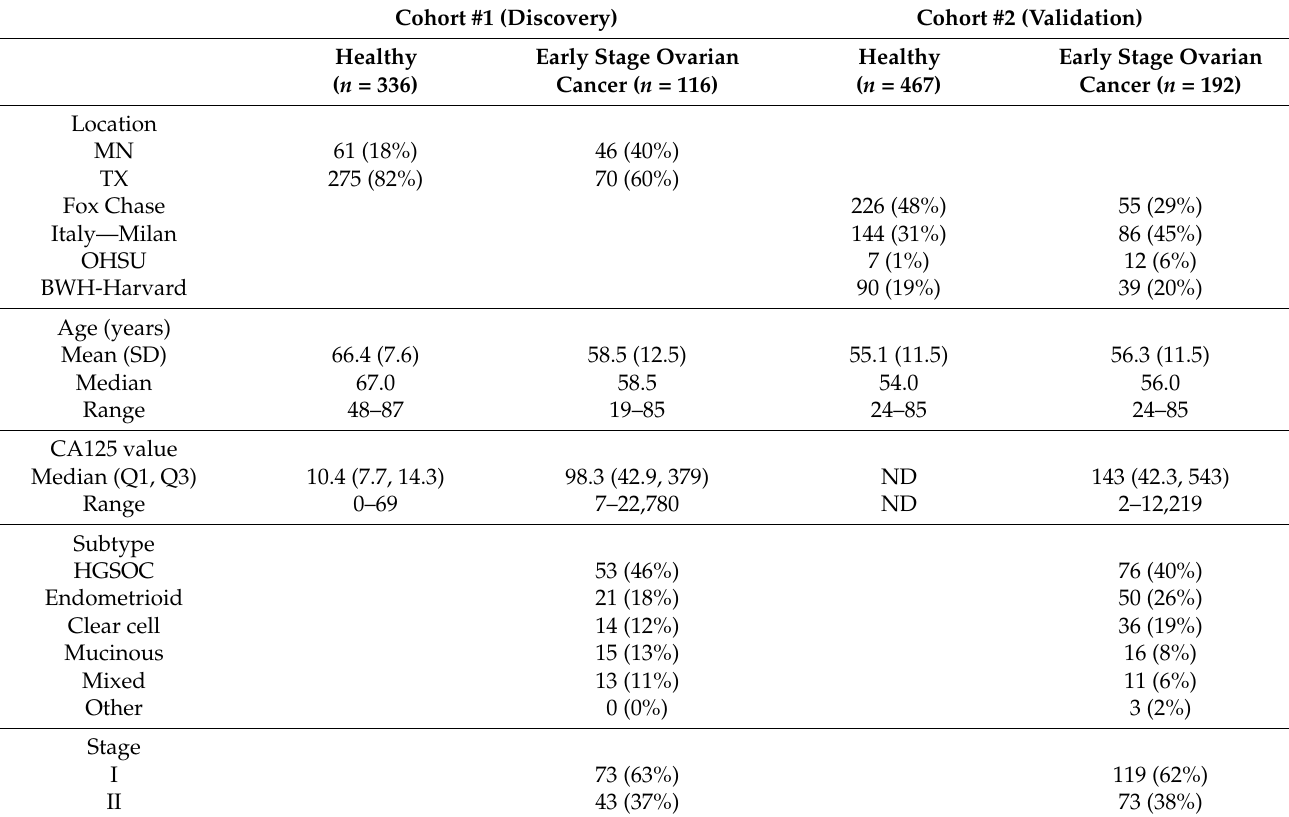
Table 1. Patient demographic information for Cohorts #1 and